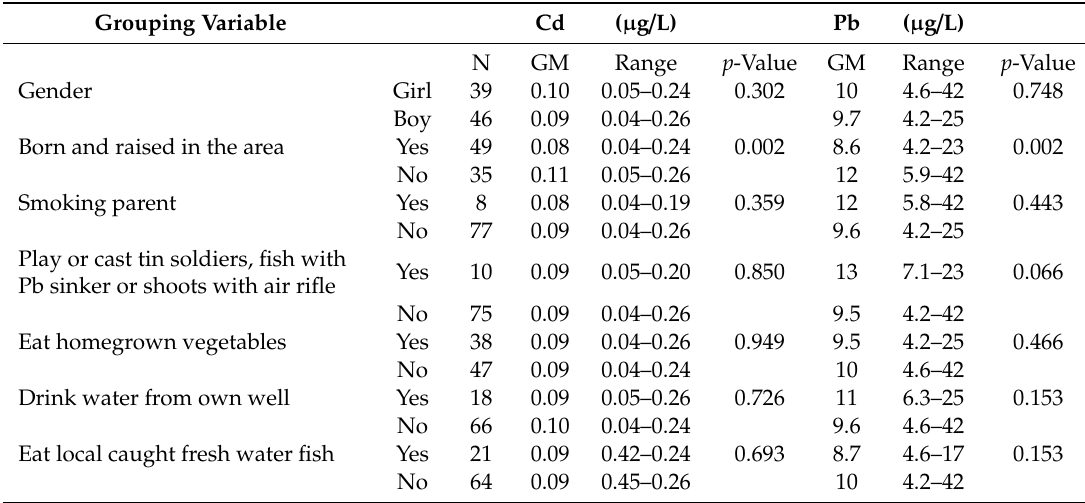
Table 3. Levels of Cd and Pb in blood for di ff erent groups in the study population. Independent t-tests have been performed between the groups to test for statistical di ff